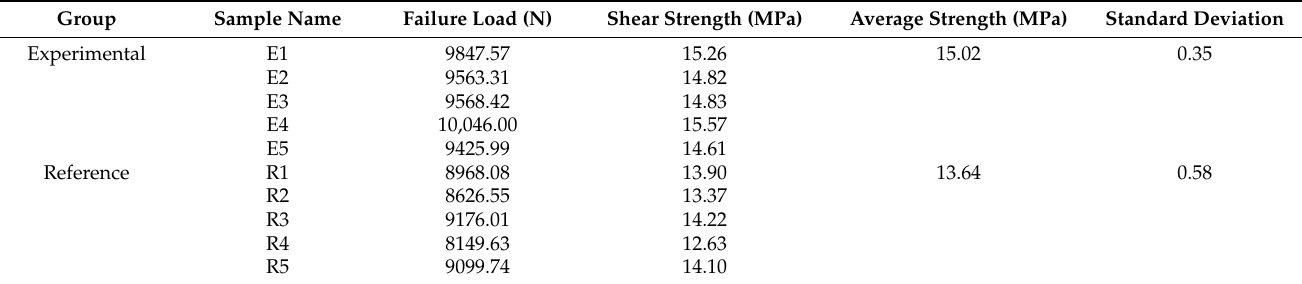
Table 5. Shear strength of the two